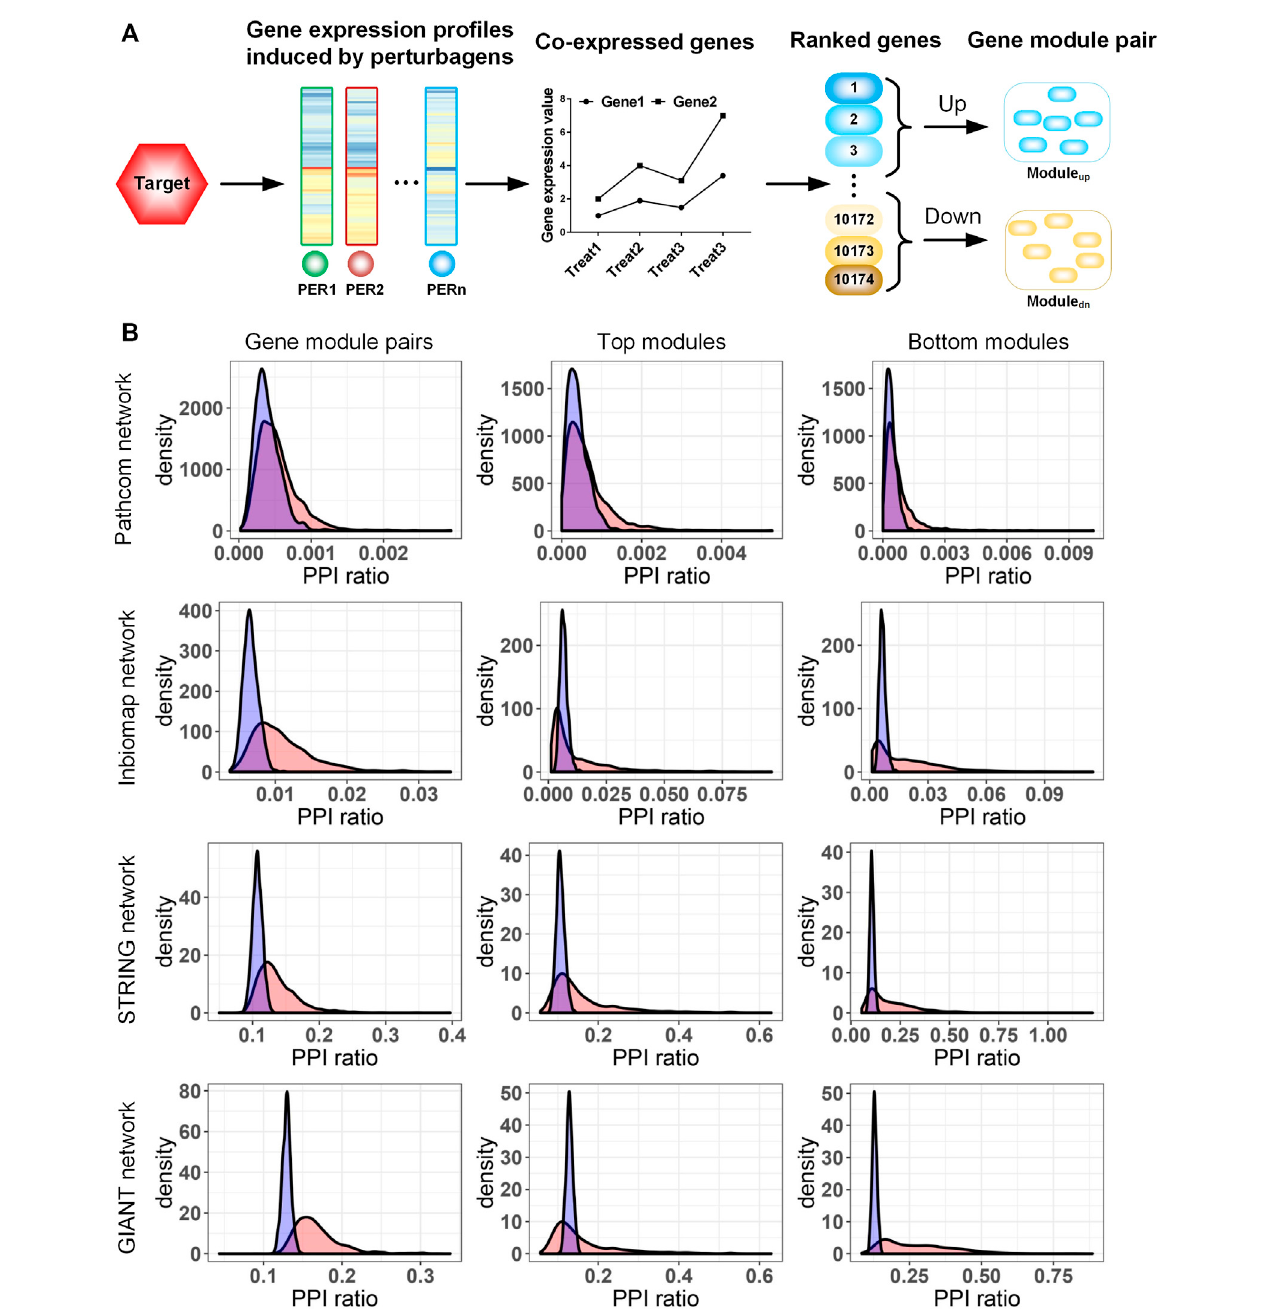
FIGURE 1 (A) Procedure to extract the gene module pair (GMP) of a target. (B) Characterization of the target-speci fi c GMP in human gene networks. Four types of gene networks were collected from Pathcom, Inbiomap, STRING, and GIANT. We evaluated the functional enrichment of module genes in each network by calculating theratioofprotein – proteininteractionnumbersamong thelinknumbers offully connected networks (PPIratio). The actual PPIratio iscompared with that of a random model to assess the signi fi cance of the enrichment. In the random model, a collection of genes with the same number as the module genes were randomly selected from the network, and then the PPI ratio was calculated. The distribution with blue and red colors is random and observed data, respectively. Rows 1 – 4 rows correspond to the analysis of the Pathcom, Inbiomap, STRING, and GIANT networks, respectively. Columns 1 – 3 correspond to analysis of gene module pairs, top modules, and bottom modules,